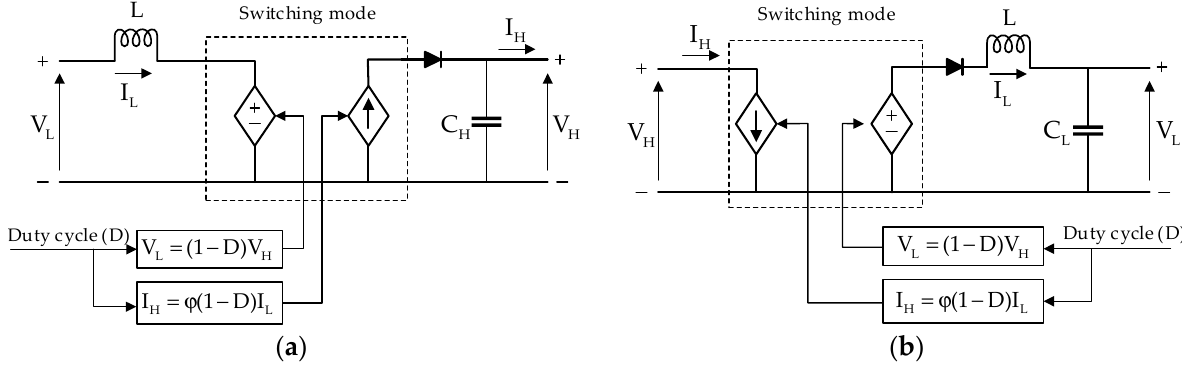
Figure 4. The average-value DC/DC converter model. ( a ) Boost mode; ( b ) Buck mode. Where D is the duty cycle (%), L is the inductance (H), ϕ is the positive gain, C L and C H are the capacitance at the low side and high side of the converter (F), respectively; V L and V H are the voltage at the low side and high side of the converter (V), respectively; I L and I H are the current at the low side and high side of the converter (A),